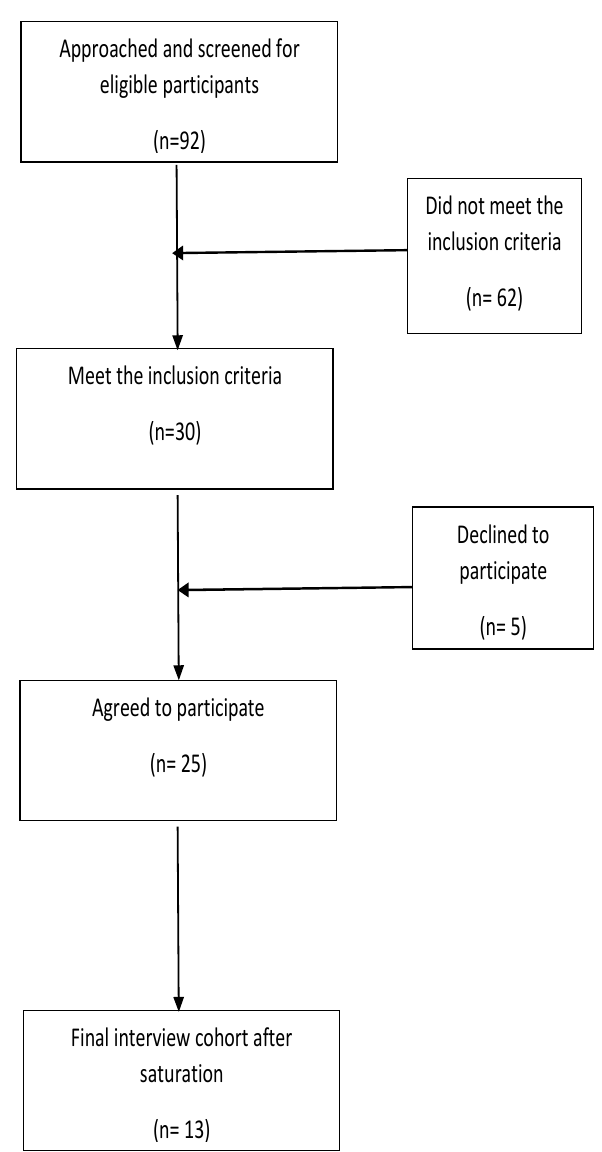
Figure 1. A flow diagram of the participants’ recruitment for the qualitative